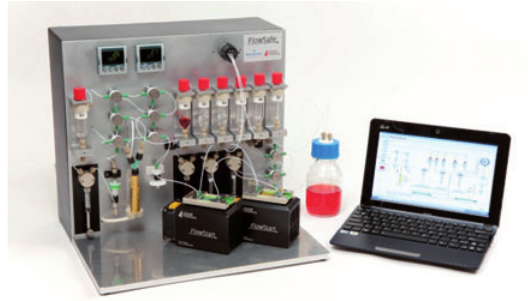
Figure 3 Flow Safe for production and development of PET-tracers in the